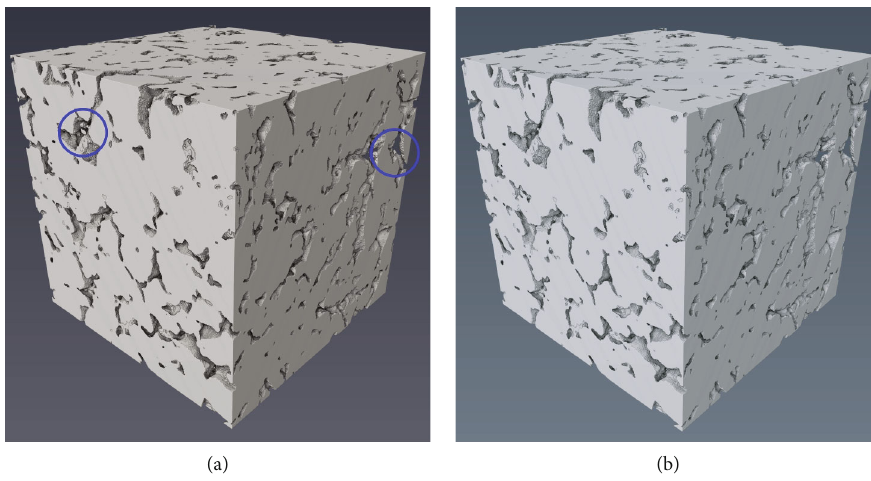
Figure 10: (a) Digital core b and (b) corrected digital core